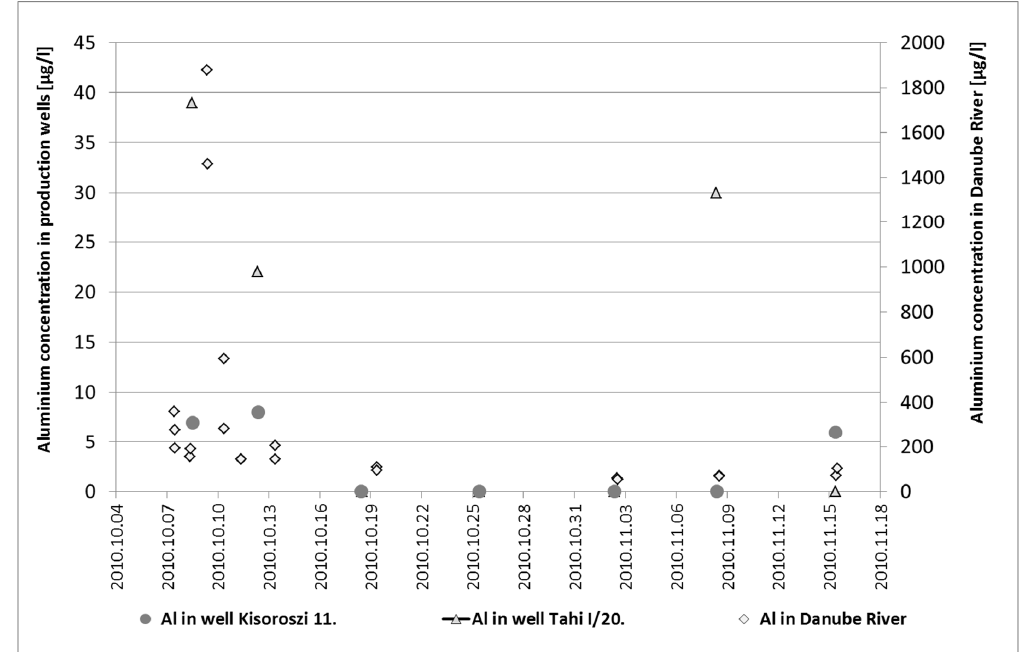
Figure 3. Aluminium concentrations in Danube River water and bank filtrate in production wells during the red mud spill in October 2010. Lower LOD is 5 µg/l for aluminium.